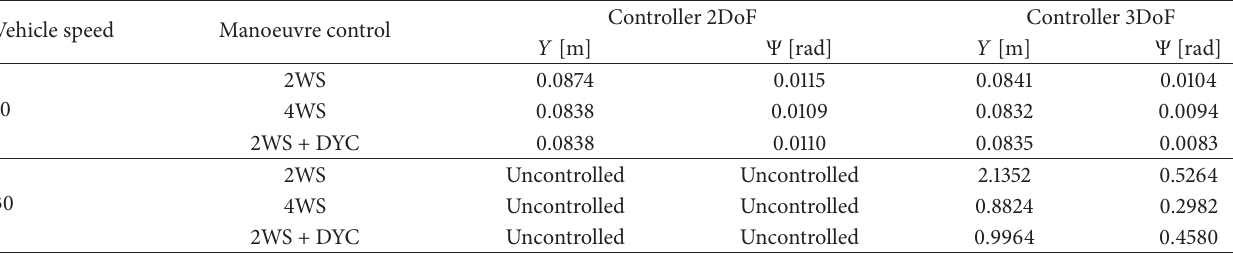
Table 6: Path following tracking errors with road friction surface 𝜇 =